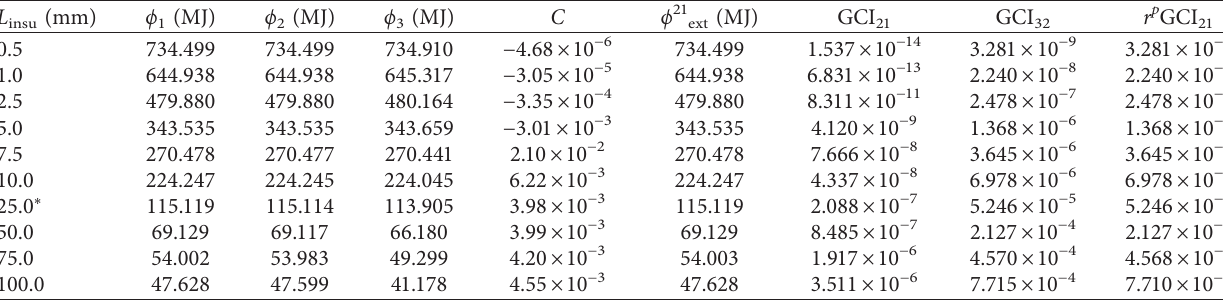
Table 4: Result of the mesh convergence study for the conduction energy gain by the thermal insulation during the kiln heating stage. L insu (mm)